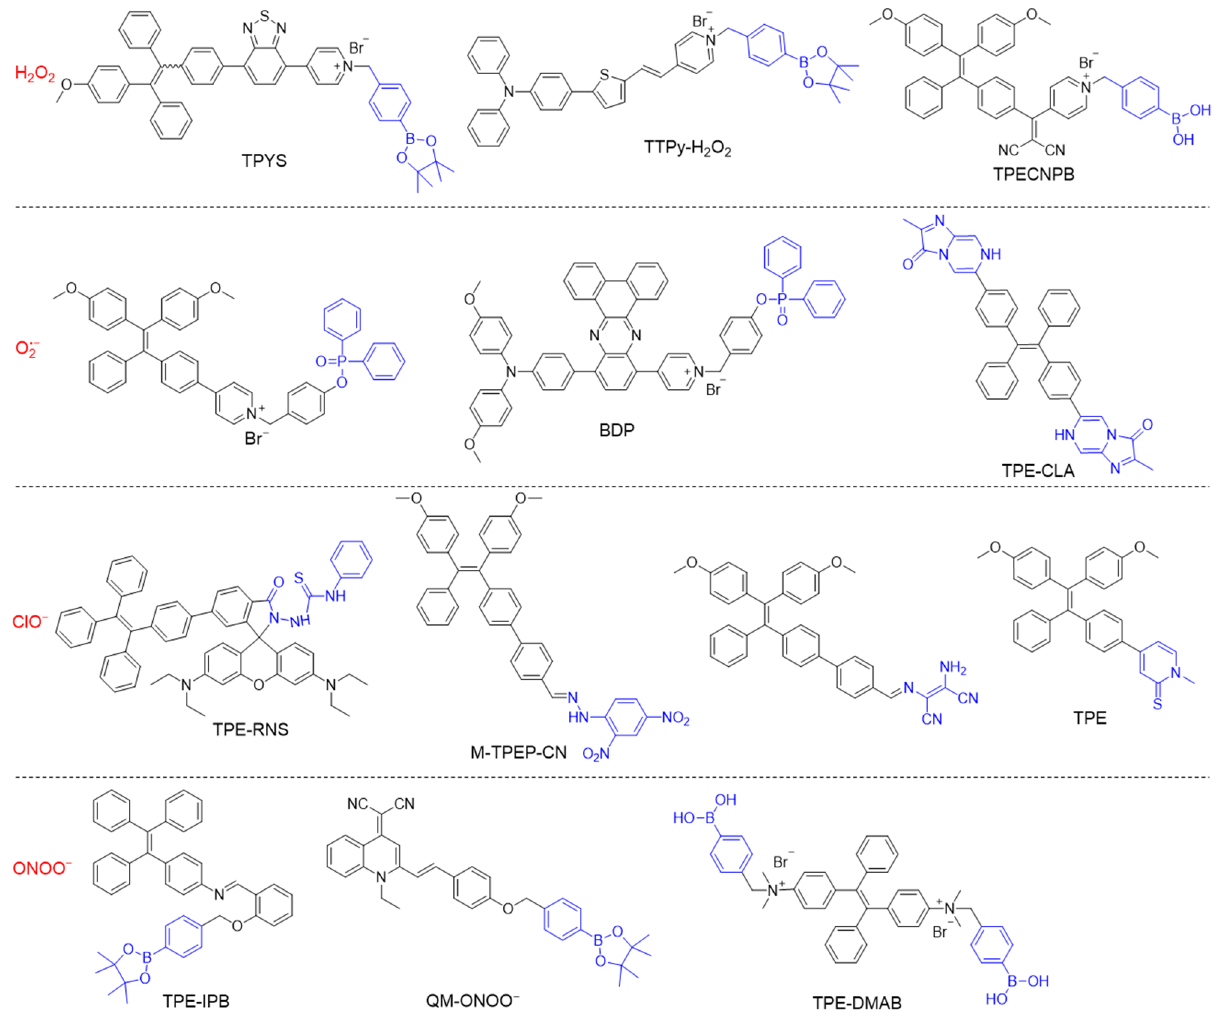
Figure 2. Chemical structures of different types of RONS-responsive molecules.